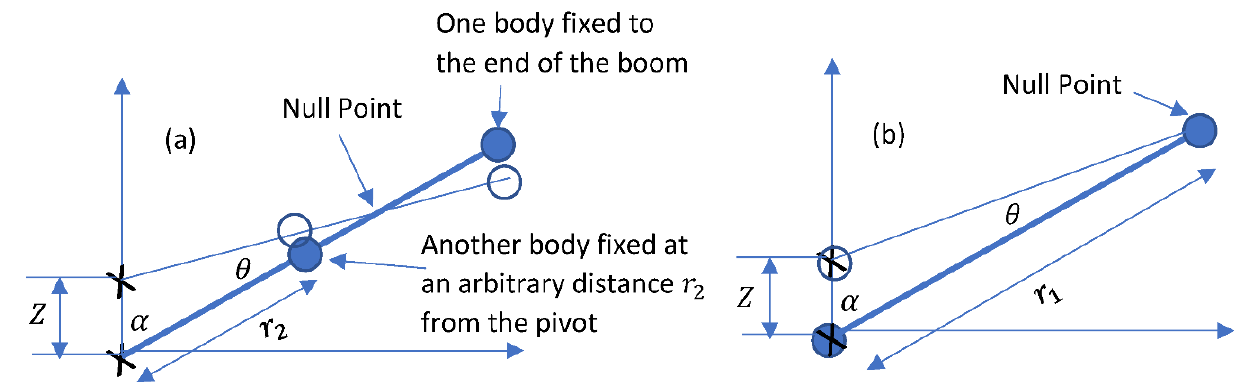
Figure 5. ( a ) Two identical bodies on a massless boom. When the ground moves up and down at high frequencies, there is a location on the boom that does not move. We call this location the Null Point. ( b ) When the movable mass is placed at or near the location of the pivot, it moves up and down with the ground and does not contribute to changing the angle 𝜃 . In this case, the Null Point down with the ground and does not contribute to changing the angle θ . In this case, the Null Point moves back to the end of the boom. moves back to the end of the